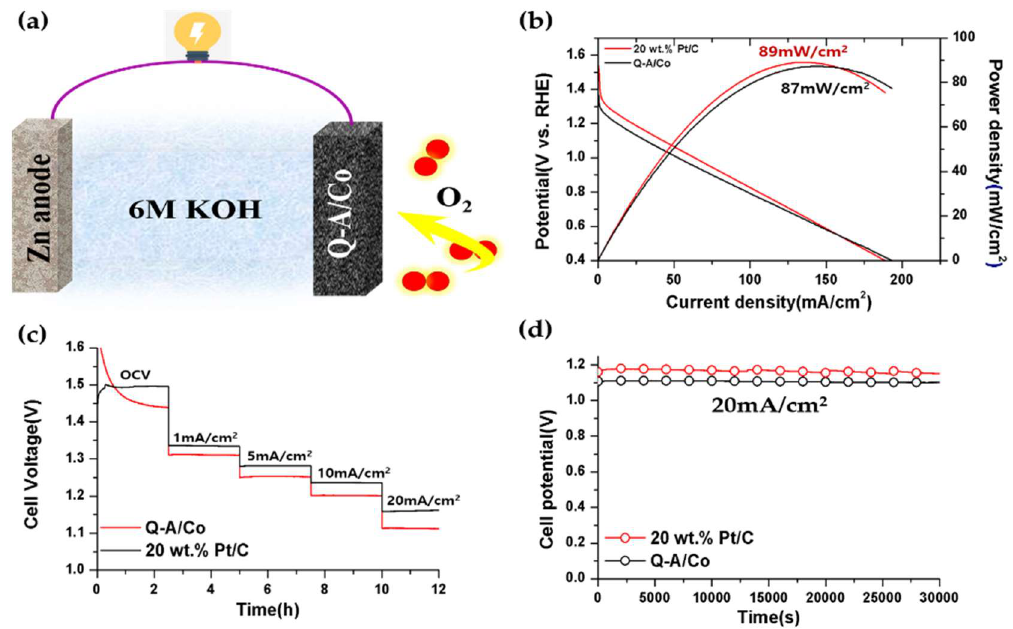
Figure 8. ( a ) Graph for the home-made Zn-air battery. ( b ) Discharge power density of Q-A/Co at 10 mV/s. ( c ) OCV and step voltage of Q-A/Co. ( d ) Discharge stability of Q-A/Co at 20 mA/cm 2 . 10 mV / s. ( c ) OCV and step voltage of Q-A / Co. ( d ) Discharge stability of Q-A / Co at 20 mA / cm 2